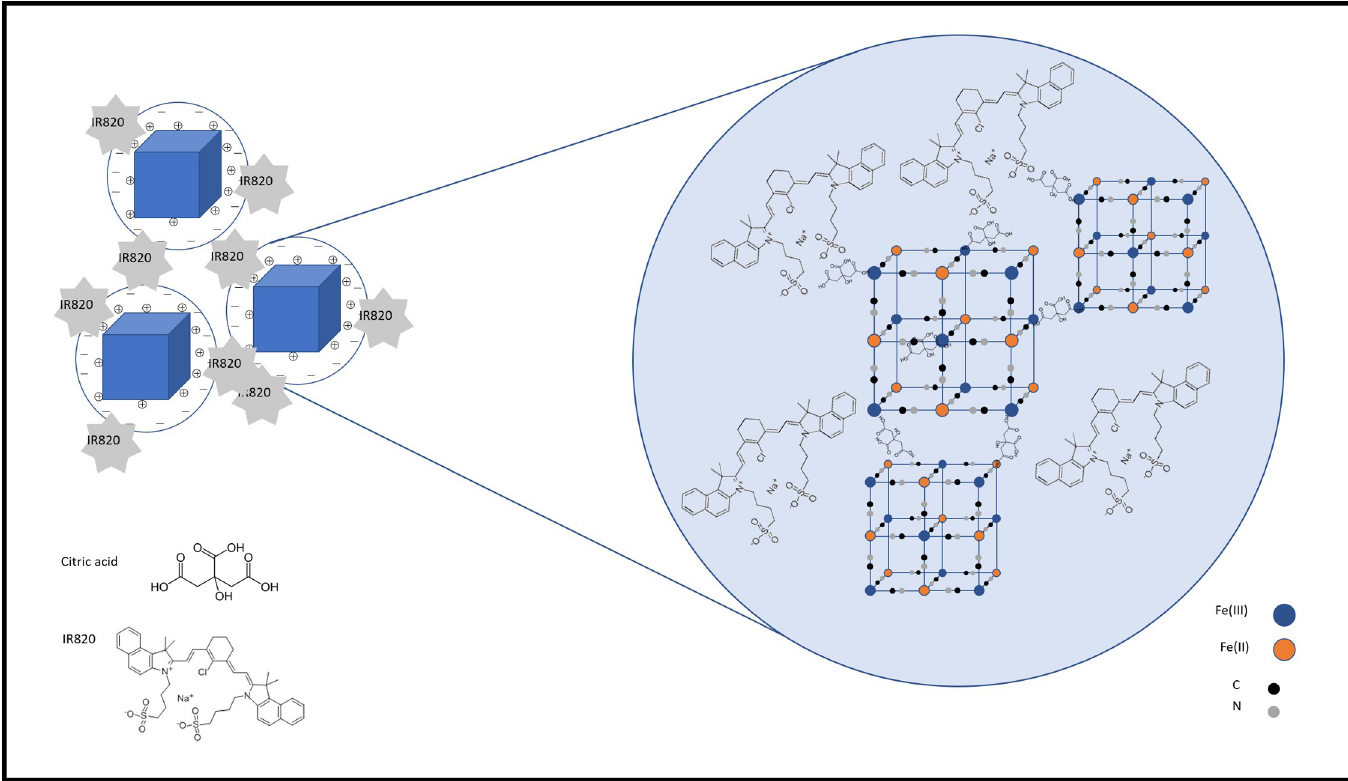
Fig 1. Schematic illustration of the presumed connection of Prussian blue nanoparticles (PBNPs) with and without coating and the particle conjugation by IR820. The blue halo around the PBNPs represent the non-biocompatible PBNP-species (PB-HCl) acting as a coating surface. The colors represent the following ions or atoms, respectively: blue: Fe (III); orange: Fe (II); black: C; gray: N.